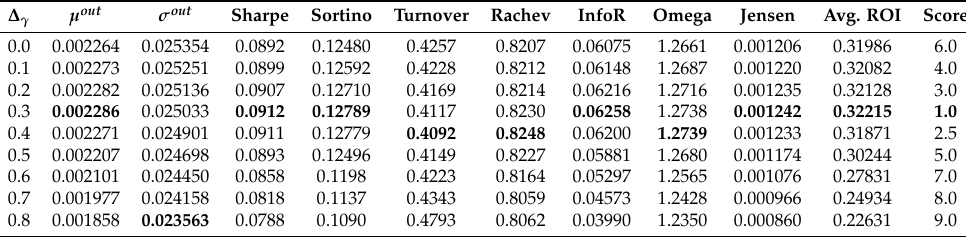
Table 13. ETF: out-of-sample performance results for the KP R strategy by varying ∆ γ .